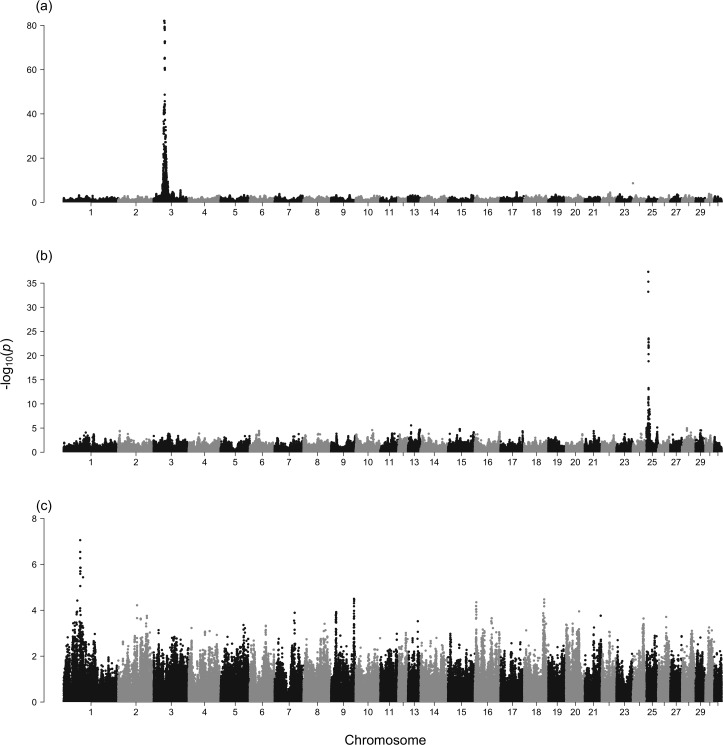
Genome-wide association analysis for known color coat loci and racing performance.Manhattan plot for (a) Chestnut coat color, (b) gray coat color, and (c) racing performance.